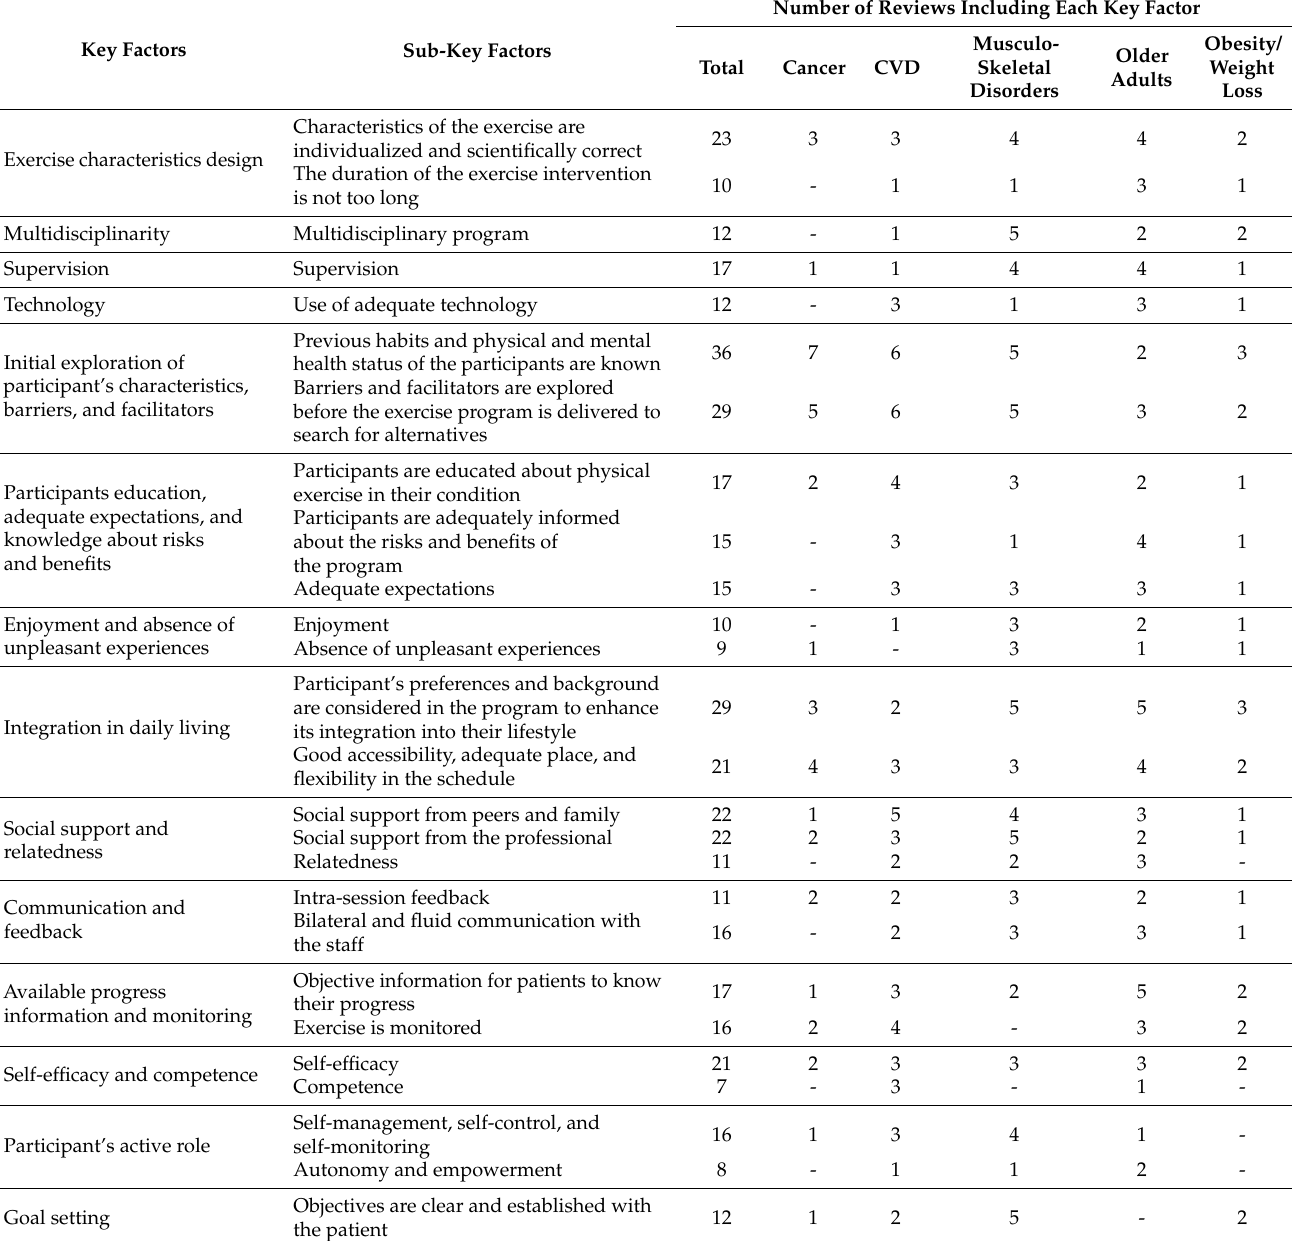
Table 2. Summary of key factors according to different